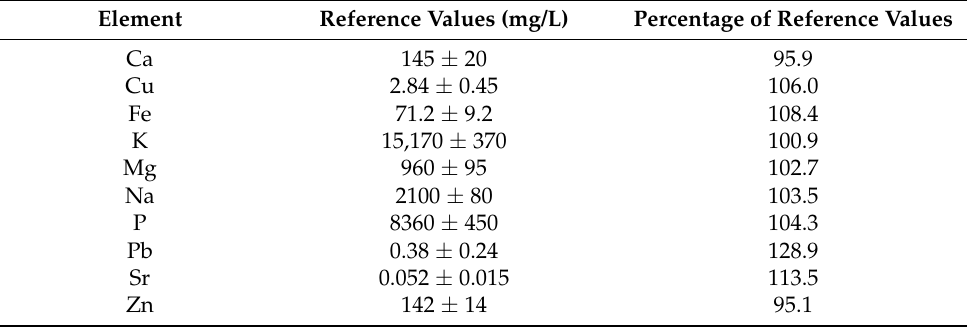
Table 2. Analysis of reference material Bovine Muscle NIST-SRM 8414.